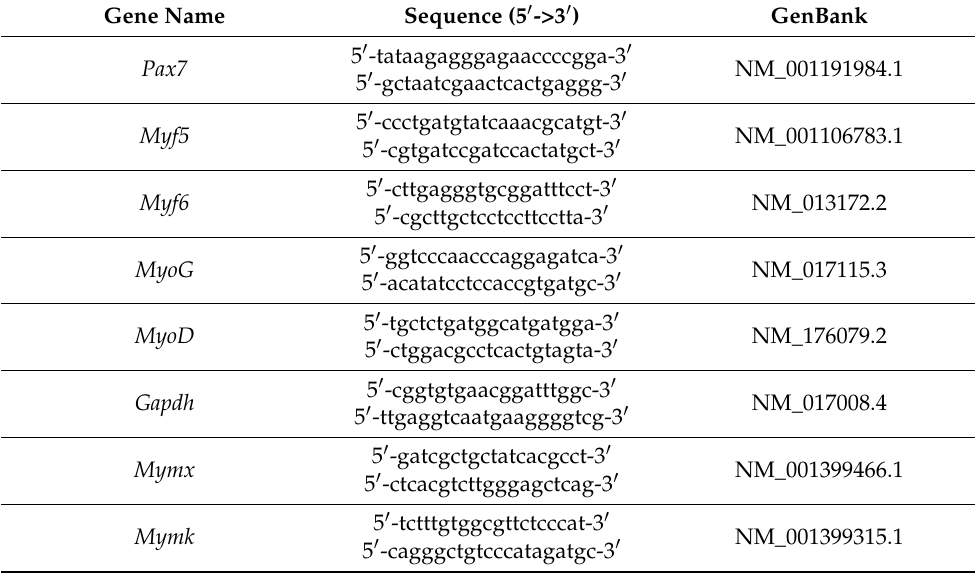
Table 4. Primers used for the qRT-PCR